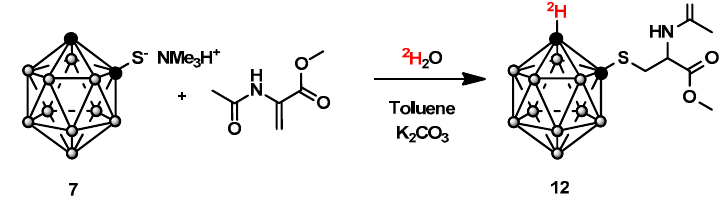
Figure 8. 1 H and a fragment of 13 C NMR spectra of 12 in CDCl 3 . 4. Discussion To summarize the obtained results, we assumed the mechanism of reaction proceeding (Scheme 5).